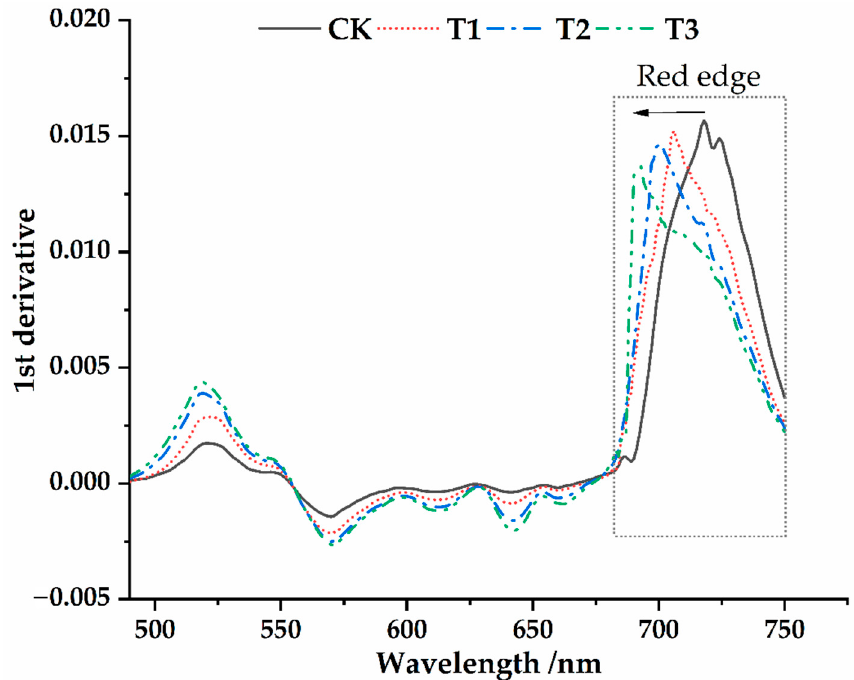
Figure 5. The first derivative spectral curves of the Osmanthus fragrans leaves.